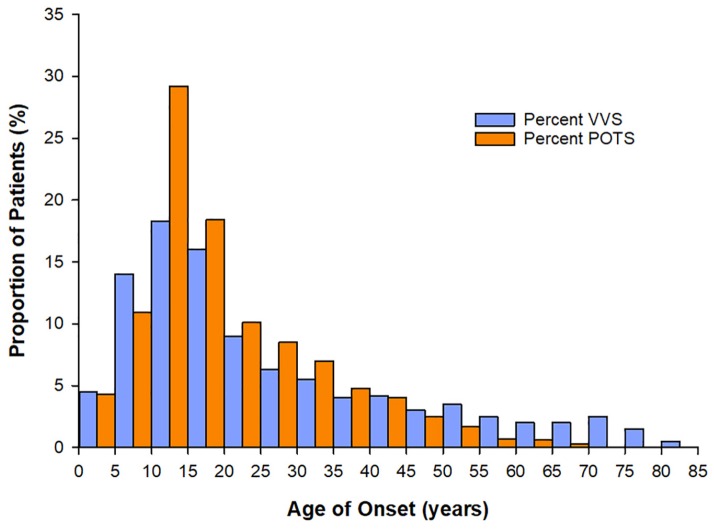
Age at onset of vasovagal syncope (VVS) and Postural Orthostatic Tachycardia Syndrome (POTS). For both patients with VVS (n = 443) and POTS (n = 4835) the peak age of onset of symptoms is between 10–15 years – coinciding with the age of onset of puberty. Data sourced from Kenny et al. (2010), Shaw et al. (2019).